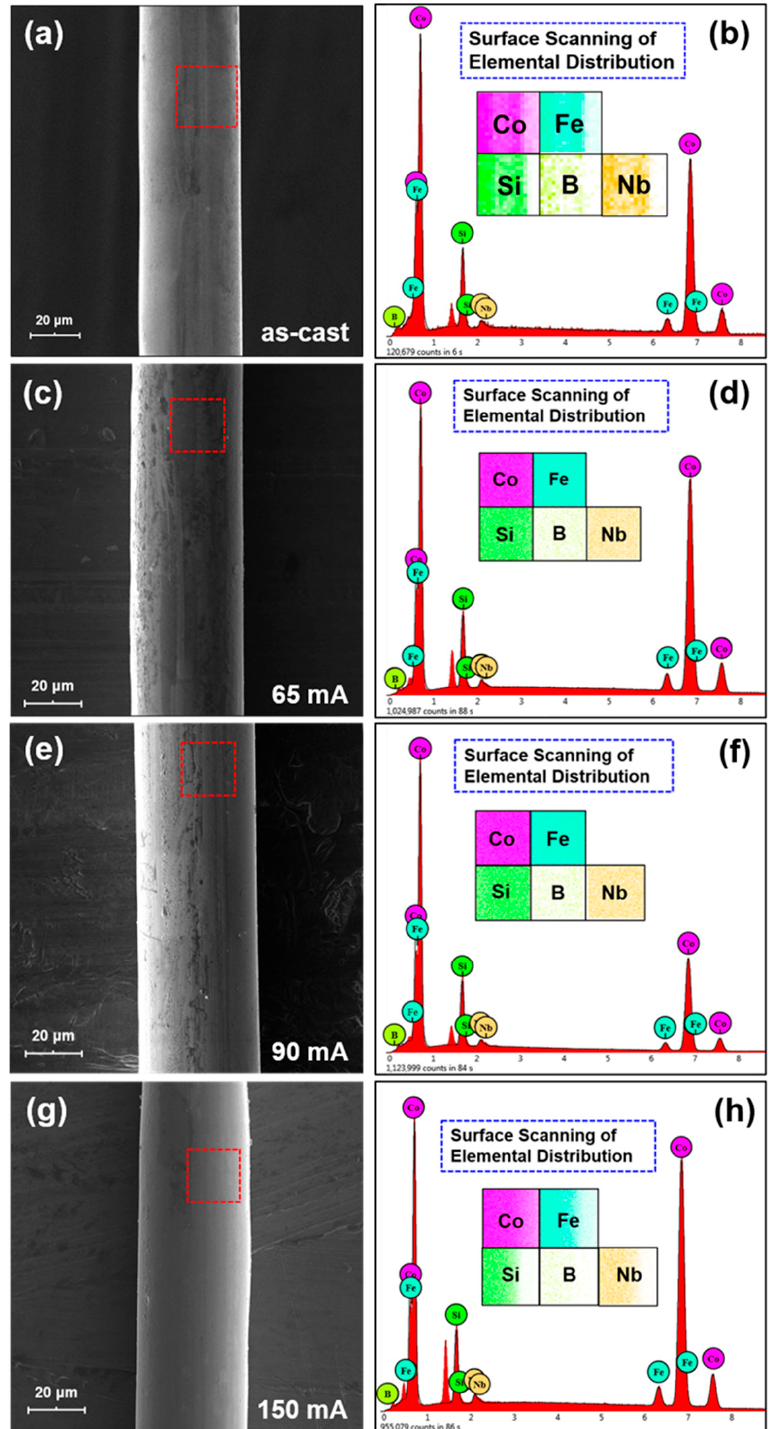
Figure 3. SEM microscopic morphology and EDS analysis of as-cast and direct current-annealed Co-based metallic microwires: ( a , b ) as-cast; ( c , d ) 65 mA; ( e , f ) 90 mA; ( g , h ) 150 mA.